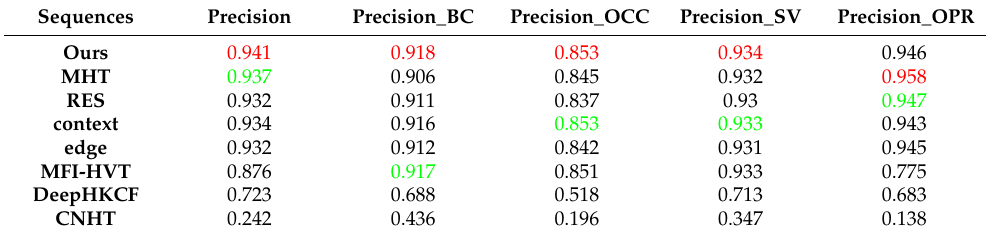
Table 2. The precision of each tracker, with a suffix indicating the challenge faced, and the top two results are highlighted in red and green respectively. The result has three significant decimal places. Sequences